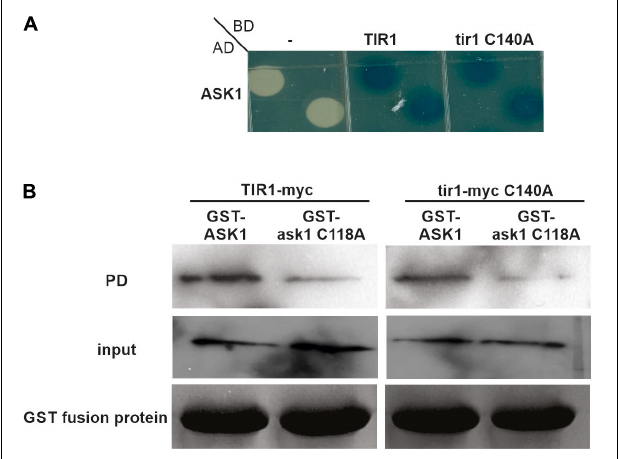
FIGURE 2 | S-nitrosation of TIR1 does not affect TIR1-ASK1 protein-protein interaction. (A) Yeasts were co-transformed with the indicated constructs and grown on SD–U–H–T selective media and X-Gal to develop β -galactosidase activity. (B) TIR1-myc or tir1-myc C140A proteins were synthesized in vitro and incubated with recombinant GST-ASK1 or GST-ask1 C118A in the presence or absence of 0.1 mM NO-Cys as S-nitrosating agent. After pull-down (PD) reactions, recovery of the TIR1 and tir1-myc C140A proteins was assessed using anti-myc antibody (top panels). The middle panel shows the input of in vitro synthesized TIR1 and tir1-myc C140A in the PD reactions, whereas lower panels show the coomassie staining of the entire PD reactions as loading control for GST-ASK1 or GST-ask1 C118A